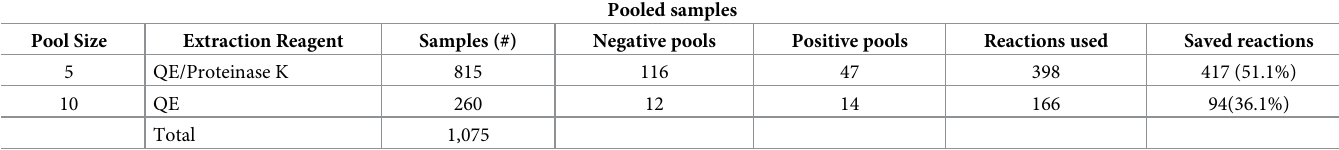
Table 1. Summary of results obtained from pools of five and ten saliva samples from patients suspected to have